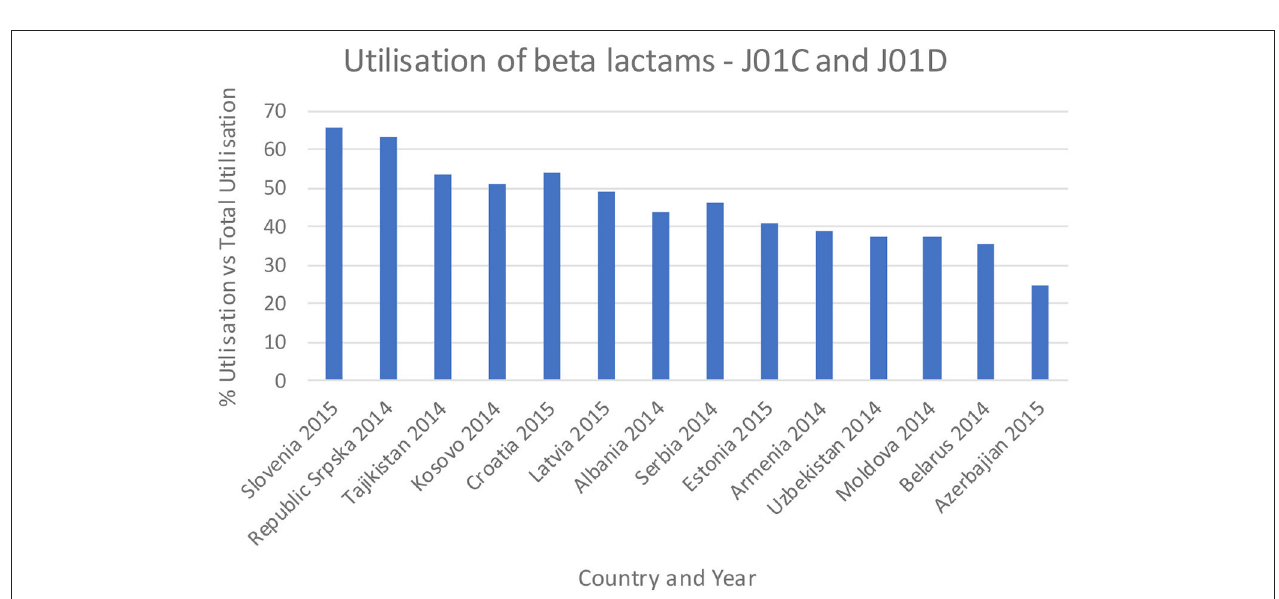
FIGURE 3 | Percentage utilization of beta-lactams as a % of total antibiotic utilization across countries (taken from Fürst et al., 2015; WHO EUROPE, 2017; ECDC,